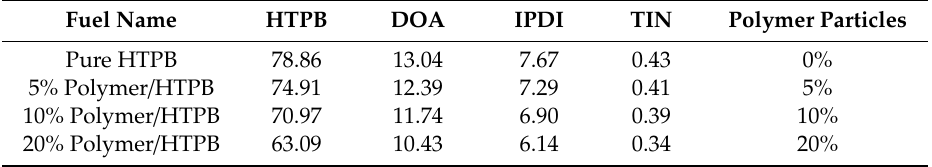
Table 2. Composition of the tested 0, 5%, 10%, and 20% polymer particles / HTPB composite